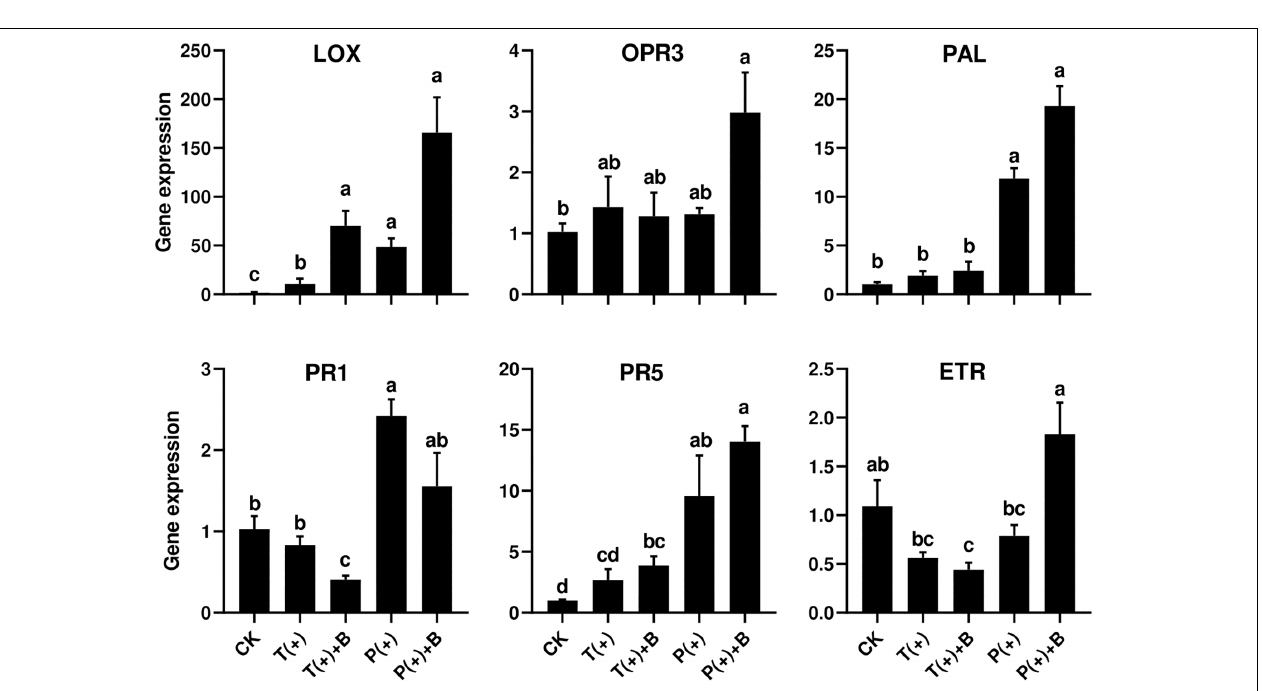
FIGURE 3 | The activity of two defense enzymes in each treatment on cucumber. Different letters above bars indicate significant differences in the quantities between control and treatment (ANOVA, P < 0.05).